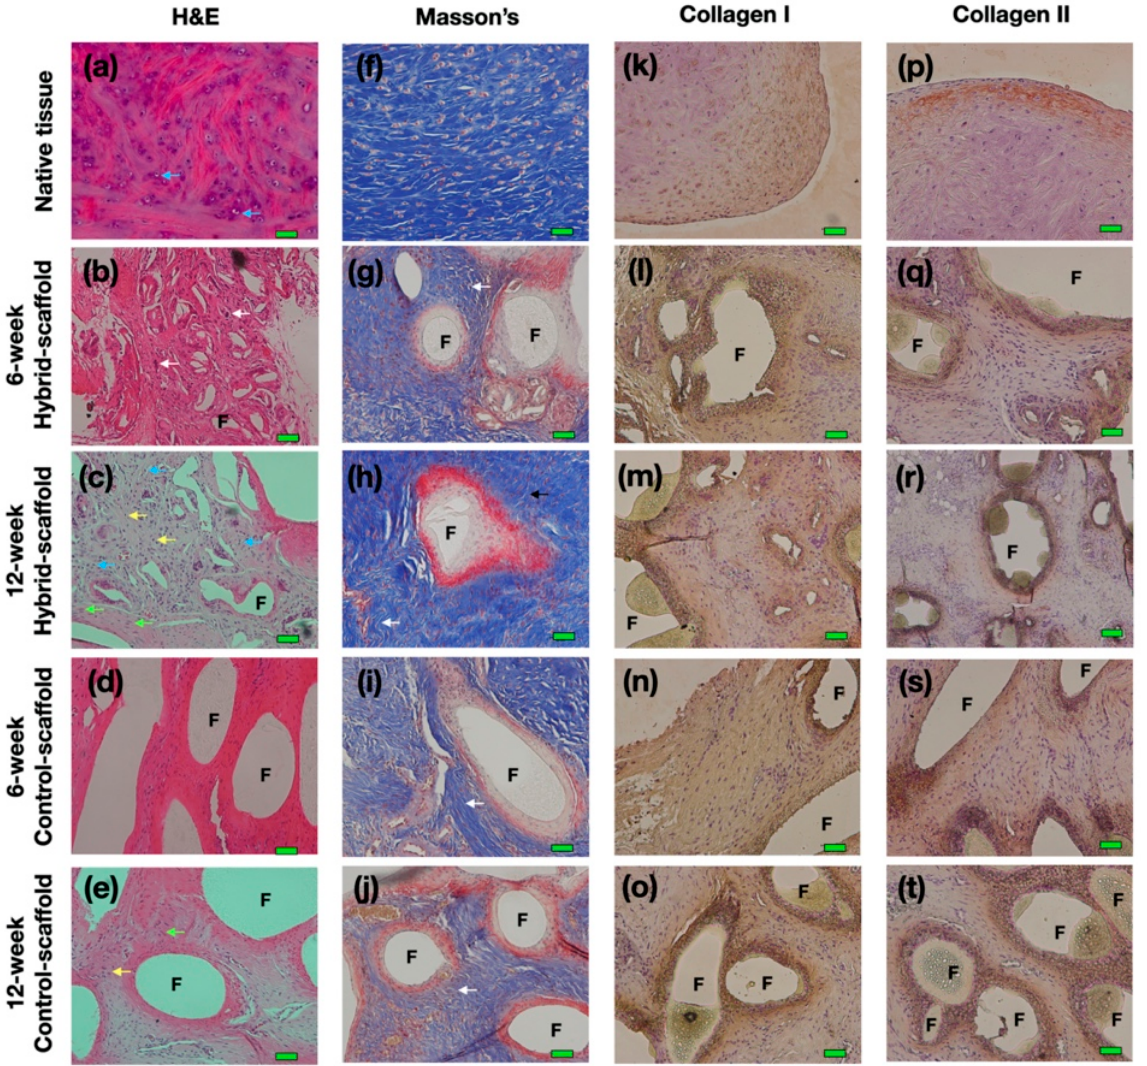
Figure 4. Histological analysis at 6- and 12-week explant. ( a–e ) Hematoxylin and eosin (H&E) stain, blue arrows depict mature lacunae, white arrows depict blood vessels, green arrows depict elongated fibroblast-like cell, yellow arrows depict round-shaped chondrocyte-like cells, ( f – j ) Masson trichrome staining, white arrows depict well-organized arrangement of collagen type I, ( k – t ) Immunohistochemical (IHC) staining. (magnification: ×200, scale bar: 50 μ m, F: polymer fibers).